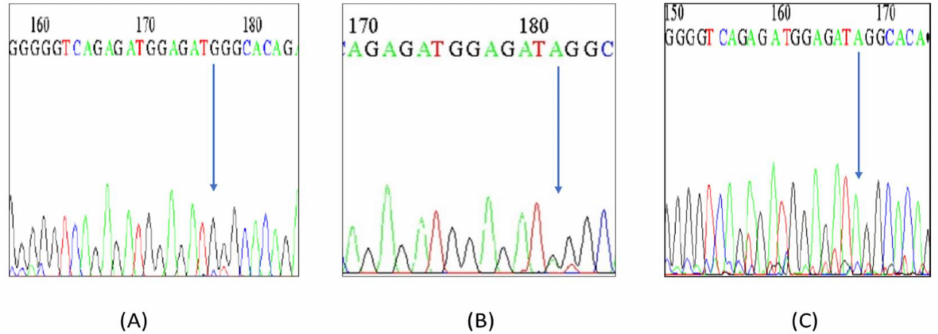
Figure 2. Reverse Sequencing of miR -125a C/T polymorphism showing partial electropherograms representing( A ) variant CC, ( B ) heterozygous CT and ( C ) TT wild